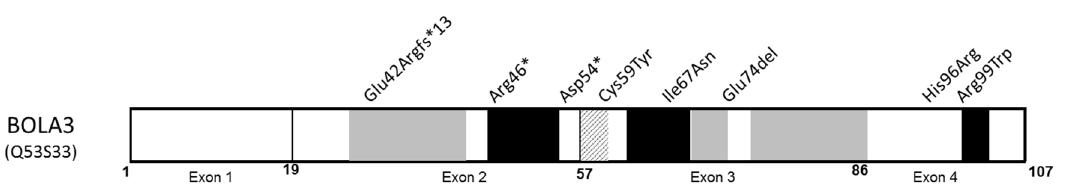
Figure 3. Schematic of BOLA3 protein (NP_997717) with reported variants. Missense variants are indicated in italic. Schematic secondary structure shows α -helix (grey), β -strand (black), and turn (grey and white crosshatchings) (adapted from UniprotKB, protein Q53S33). A mitochondrial targeted sequence has not yet been formally identified.